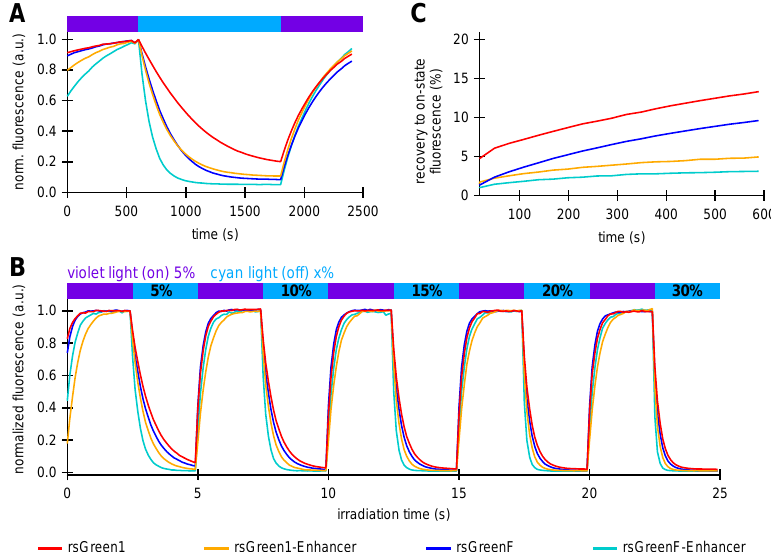
Figure 3. The effect of Enhancer nanobody binding on the photoswitching behavior of rsGreens. ( A ) Normalized average fluorescence of E. coli colonies expressing indicated FPs upon irradiation with violet, blue and violet light. ( B ) Normalized average fluorescence in HeLa cells upon irradiation with violet and cyan light with indicated preset powers. ( C ) Spontaneous, thermal recovery of the fluorescence in HeLa cells after off-switching with cyan light. a.u.: arbitrary